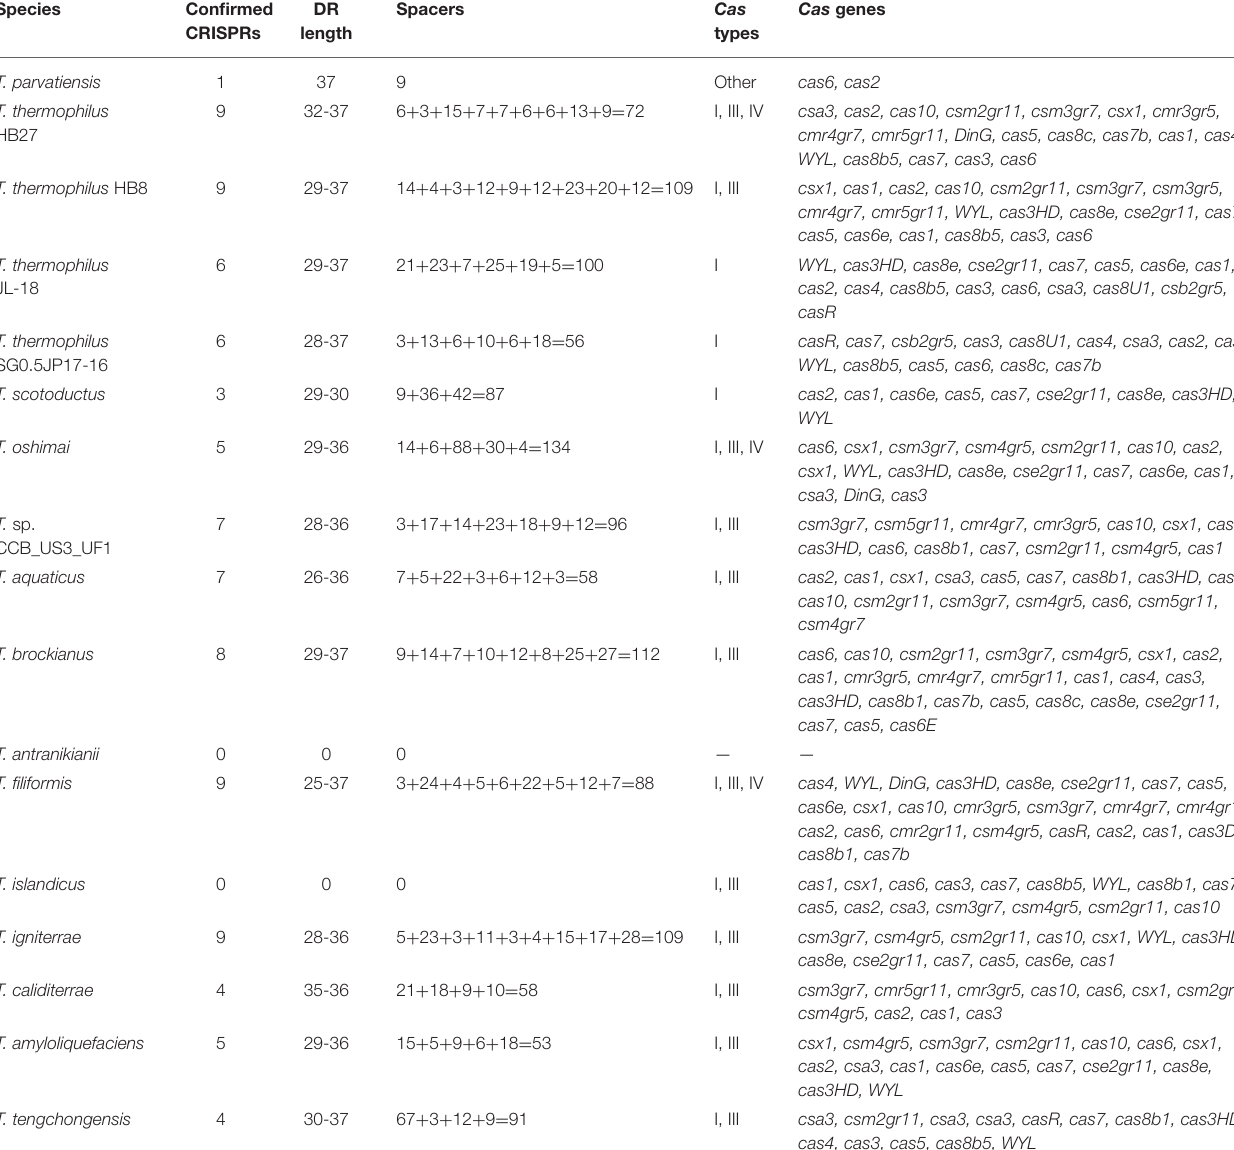
TABLE 3 | Summary of CRISPR elements found across all Thermus genomes under this study. Species Confirmed DR CRISPRs